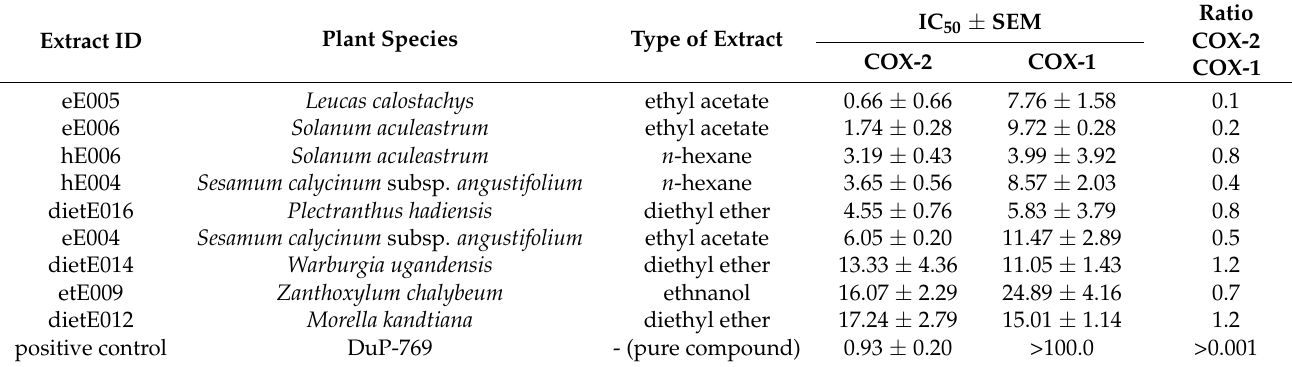
Table 2. Results of COX-2 and COX-1 inhibition by medicinal plant samples from the Greater Mpigi region in Uganda; extracts are sorted from highest to lowest COX-2 sensitivity; IC 50 values are given in µ g/mL (positive control: ng/mL); SEM = standard error of the